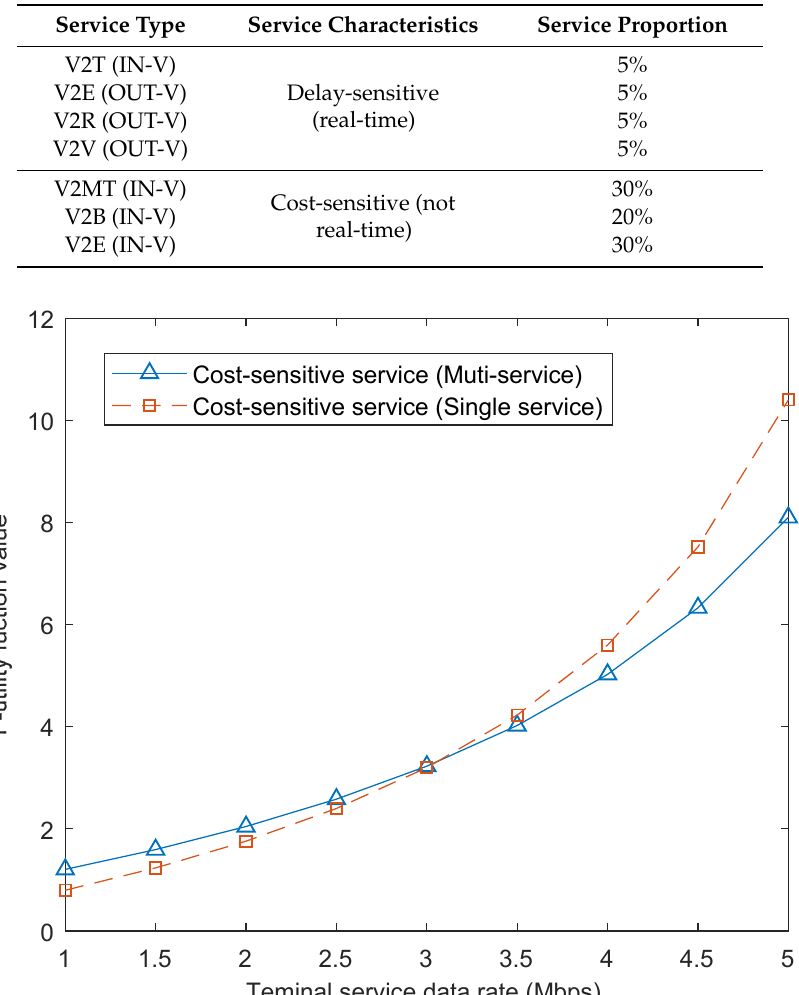
Figure 8. Cost-sensitive service utility value comparison results.